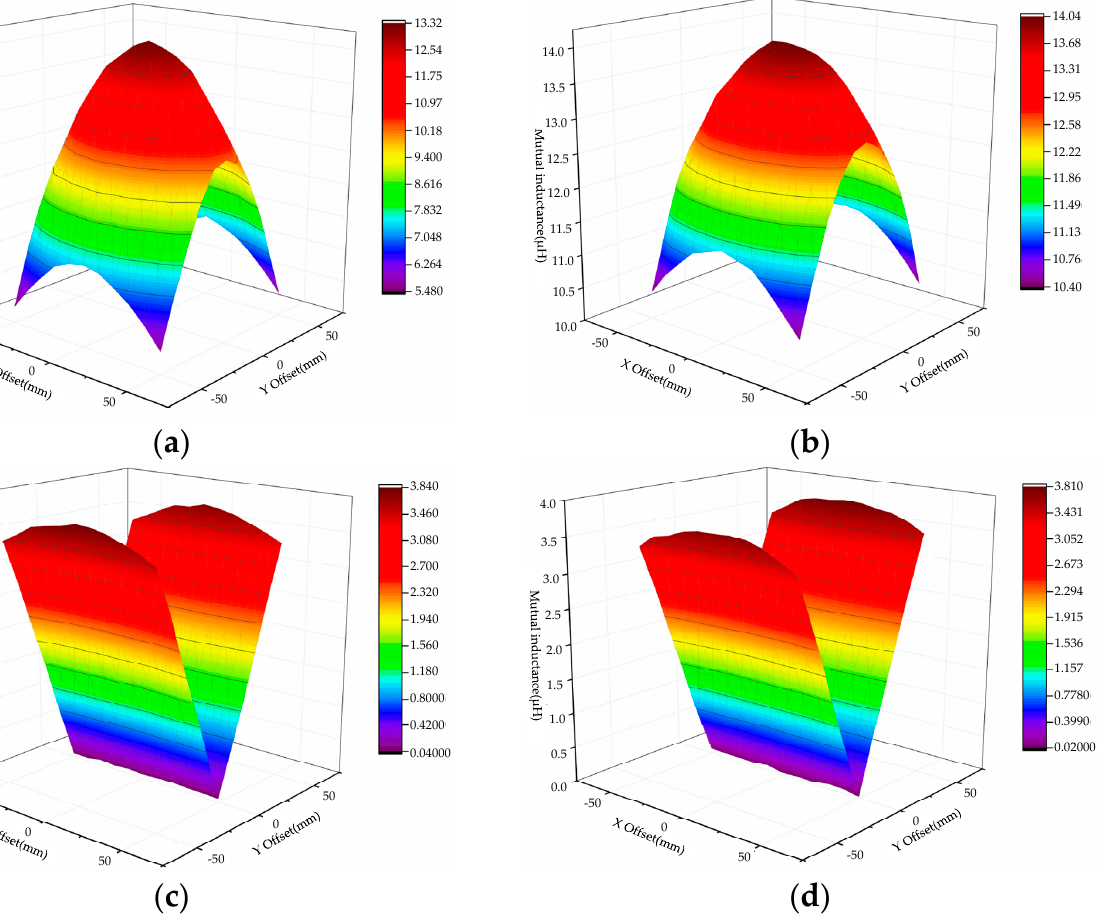
Figure 5. Interoperability of DD coil and rectangular coil ( a ) Rectangular transmitter–rectangular receiver; ( b ) DD transmitter–DD receiver ( c ) Rectangular transmitter–DD receiver; ( d ) DD transmitter–rectangular receiver. Reprinted from Ref. [59].